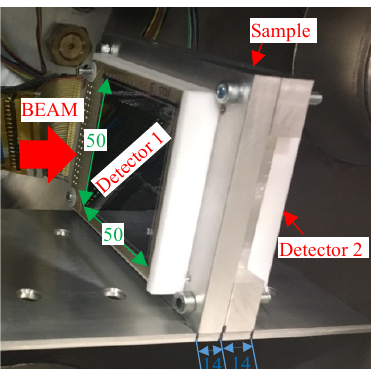
Fig. 3. Image of the detectors and sample support. The Detector 1-sample and sample-Detector 2 distances are indicated in blue. Dimensions are given in mm. all built on a 500 µ m PVC matrix layer. The first sample, shown on the left-hand side, contains a cross pattern made with a 200- µ m-thick aluminum layer on top of the PVC layer. The second sample, which can be seen at the center of Fig. 4, contained four different circular regions of 10(1) mm diameter each: one with only a 200- µ m-thick aluminum layer (1), another with just a hole (2), a third one containing 200- µ m-thick aluminum layer on top of the 500- µ m-thick PVC matrix (3) and the last one built with 1-mm-thick aluminum (4). The third sample was built with holes of different diameters and separations emulating a Derenzo pattern. The holes and separations are of 4, 6 and 8 mm